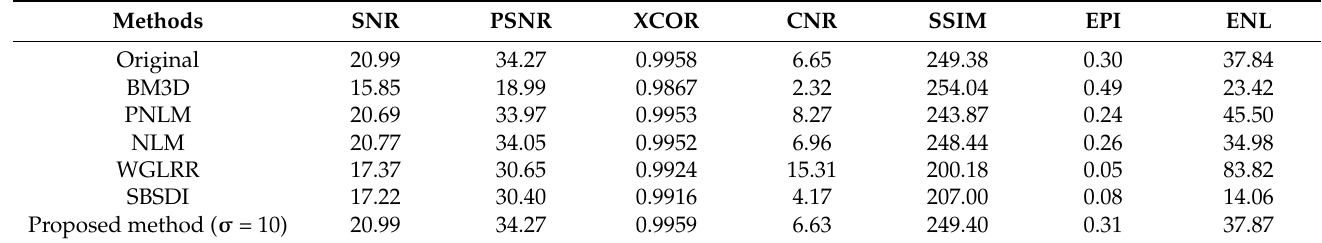
Table 2. Quantitative evaluations of the different noise reduction methods.